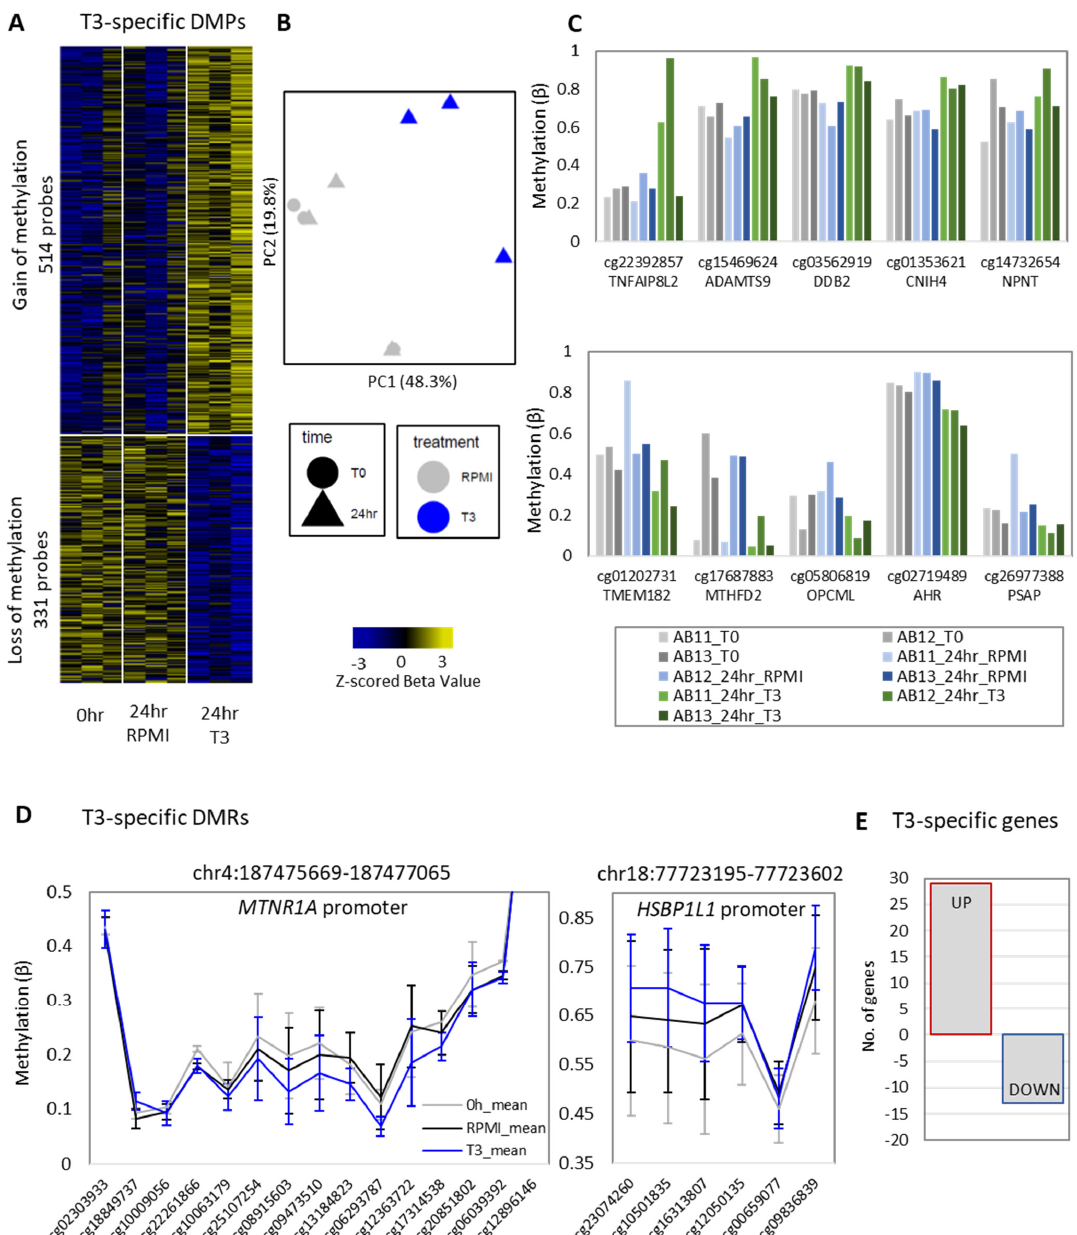
Figure 2. T3 treatment induces a specific methylation signature in human monocytes. ( A ). We iden- tified 845 T3-induced DMPs, with 514 showing a gain of methylation relative to RPMI and 0 h con- trols ( Δβ > 0.05, unadjusted p -value < 0.05), and 331 showing a loss of methylation (Z-scored indi- vidual donor β values) ( B ). Separation of T3 samples from controls on a PCA plot based on DMPs (separation on PC1). ( C ). Strongest T3-induced gain-of-methylation DMPs (top) and loss-of-meth- ylation DMPs (bottom) and nearest gene. ( D ). An example of a T3-induced loss-of-methylation DMR in the MTNR1A promoter and a T3-induced gain-of-methylation DMR in the HSBP1L1 promoter. Error bars show 95% confidence intervals. For a comprehensive figure of all T3-induced DMRs, see Figure S3C,D. DMRs were identified using DMRcate, with a minimum of 3 CpGs in the DMR, a p -